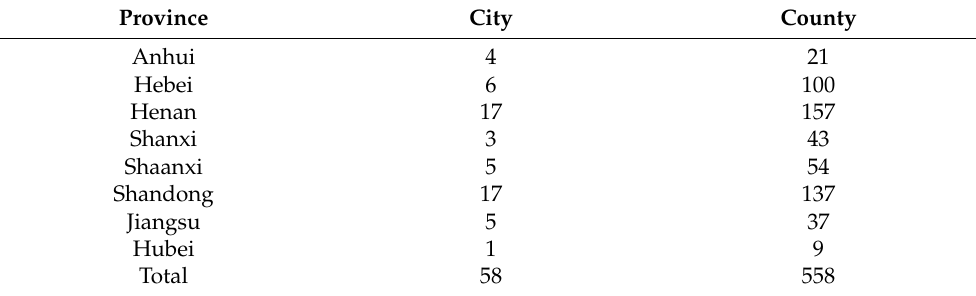
Table 1. Distribution of cities in Huang-Huai-Hai ecological region.